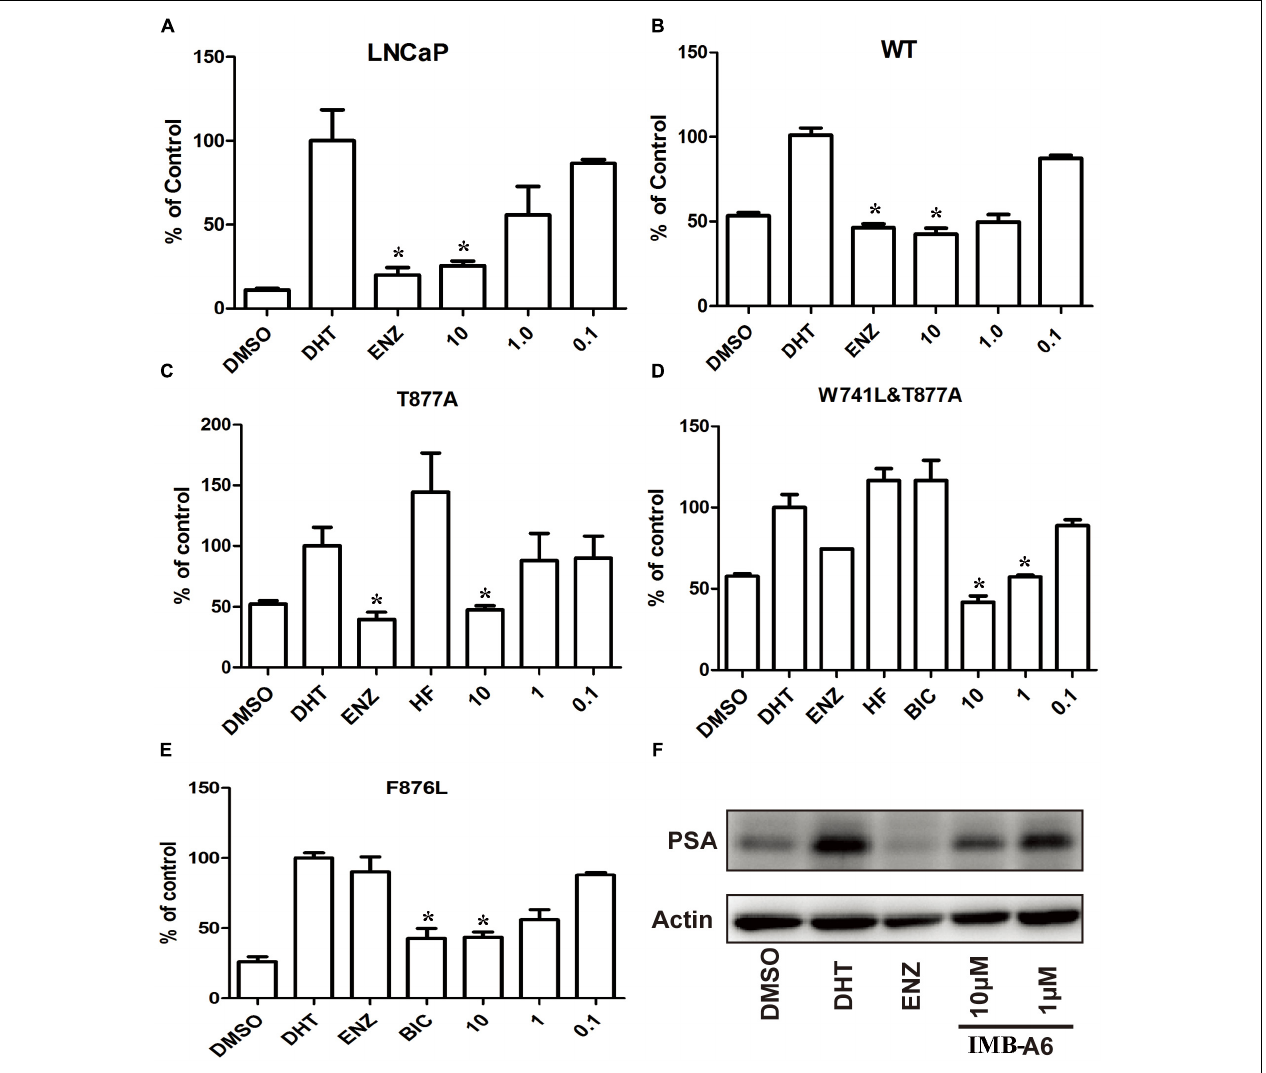
FIGURE 3 | IMB-A6 is identified as a pan antiandrogen. (A) Effect of IMB-A6 on AR activity in LNCaP cells. (B) Effect of IMB-A6 on WT AR activity in PC-3 cells. (C) Effect of IMB-A6 on T877A AR activity in PC-3 cells. The T877A mutated AR was activated by hydroxyflutamide at 5 µ M. (D) Effect of IMB-A6 on W741L + T877A AR activity in PC-3 cells. The T877A + W741C mutated AR was activated by both hydroxyflutamide and bicalutamide at 5 µ M. (E) Effect of IMB-A6 on F876L AR activity in PC-3 cells. The F876L mutated AR was activated by enzalutamide at 5 µ M. (F) Western blot analysis indicated that IMB-A6 suppressed DHT induced PSA protein expression in LNCaP cells at 1 and 10 µ M. Plasmids expressing ARs were transiently transfected in PC-3 cells in dual luciferase assay. Experiments were in triplicate. ∗ P < 0.05, ∗∗ P < 0.01 vs. DHT group. BIC, bicalutamide; HF, hydroxyflutamide; ENZ, enzalutamide; DHT, dihydrotestosterone. All results are shown as mean ±